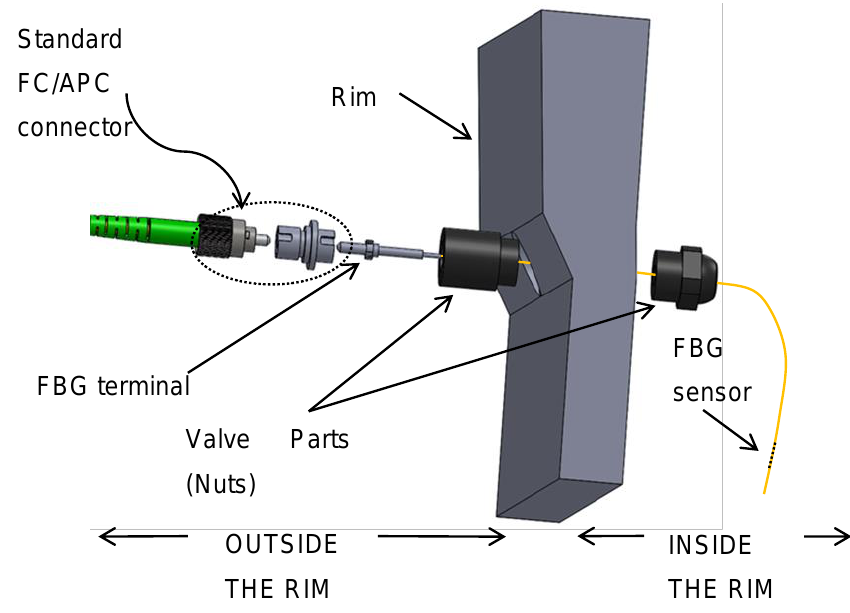
Figure 6. Exploded diagram of FBG valve.